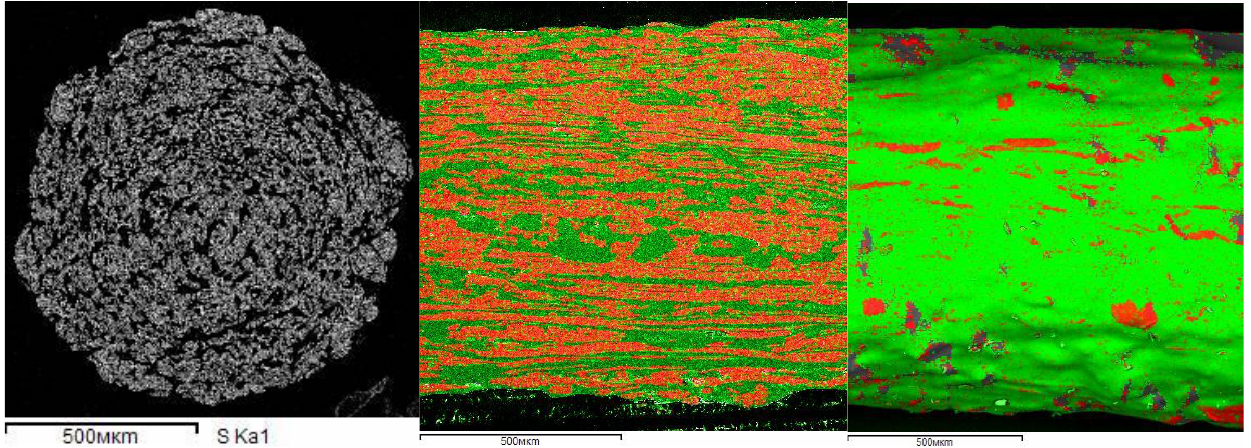
Figure 27. Cross section ( left ), longitudinal cutting ( middle ) and a surface ( right ) of an extrudate of the mixture PSF:LCP (50:50).